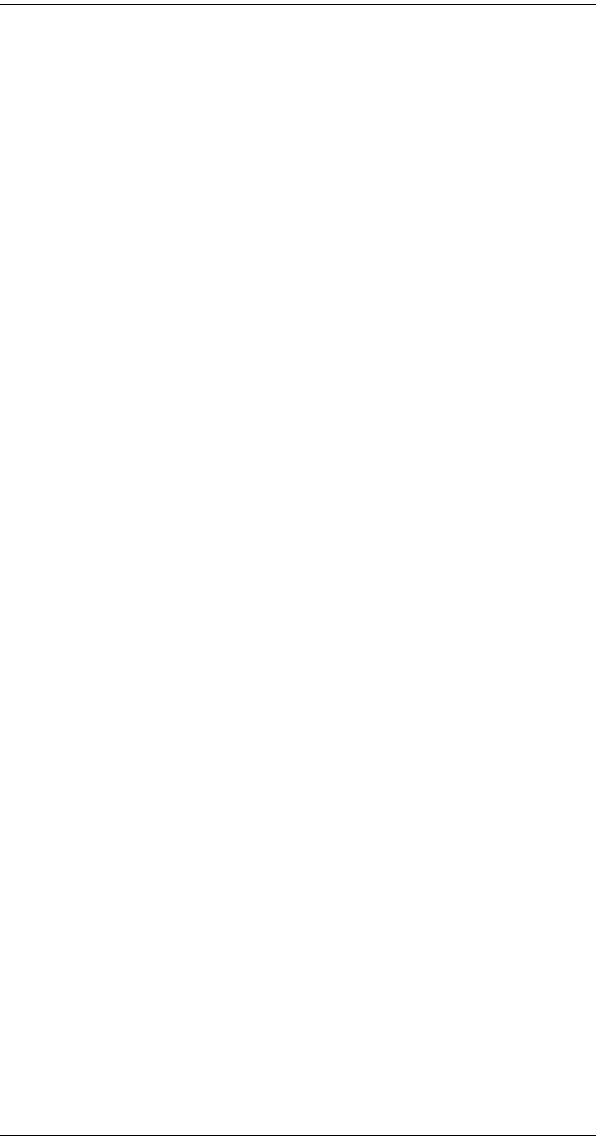
score is computed resulting in a list of LONR score for each mutation. For genetic region, the LONR score of the mutations in this regions are analyzed and the resulting p -value is the result of a t -test between S and NS